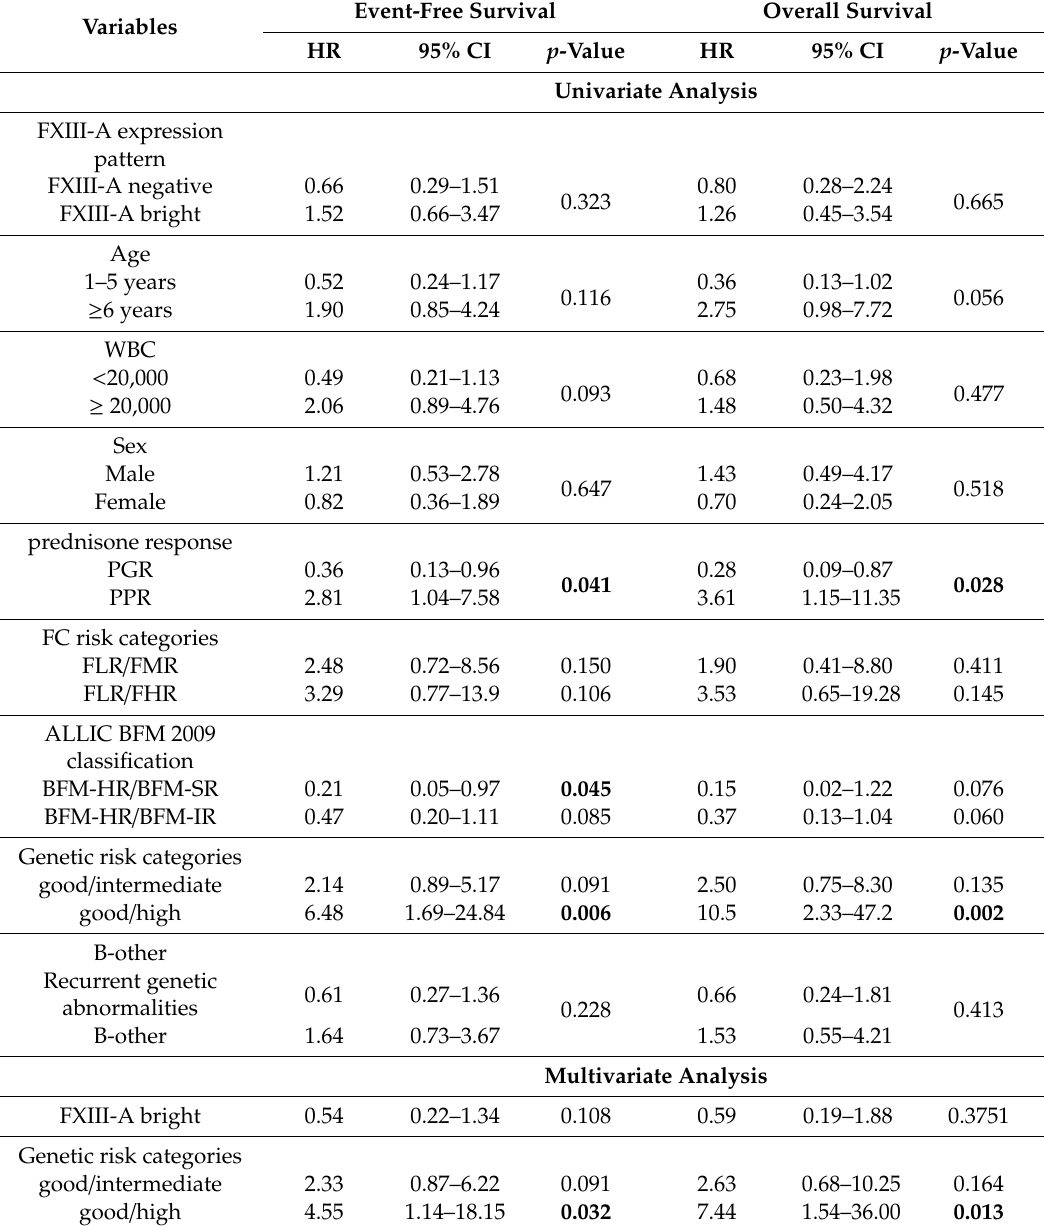
Table 3. Association of categorical variables on event-free survival (EFS) and OS of the FXIII-A negative vs. bright groups by univariate and multivariate Cox regression